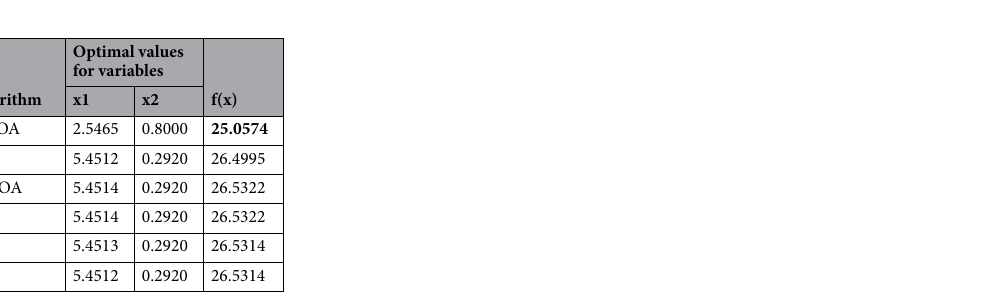
Table 27. Results of LFGOA and competitive algorithms in solving the tubular column design. The best of the comparison results are in [bold].